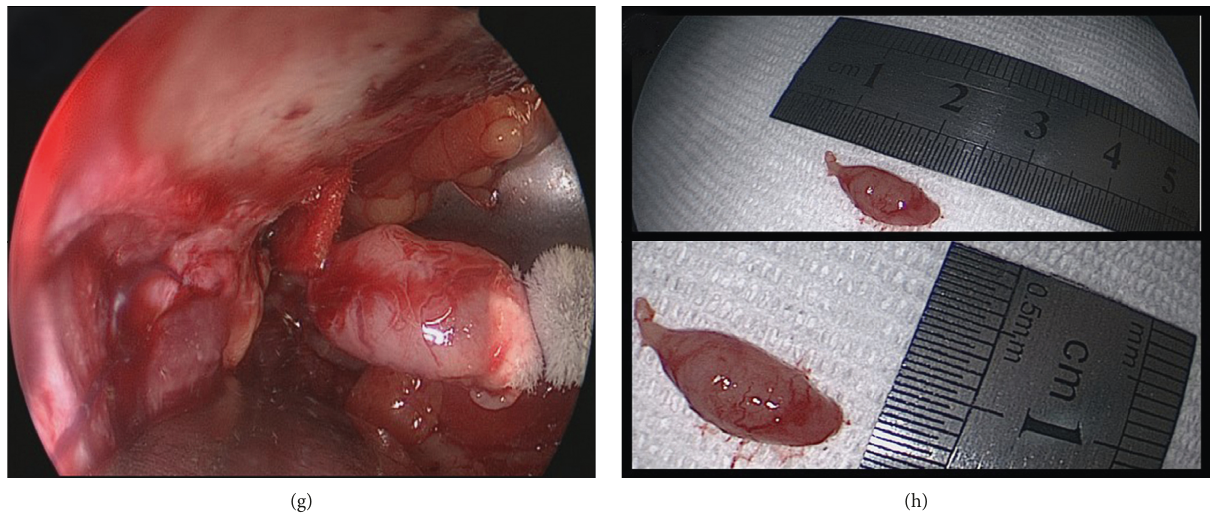
Figure 1: Surgical view of removal of the tumor at the lateral orbital apex with a navigation-guided endoscope. (a) Matching the patient’s anatomical landmark with imaging date. (b) Lateral orbitotomy removed the lateral wall. (c, d) Removing the lateral wall to expose the apex and access the tumor (white arrow) under a navigation-guided endoscope. (e, f) Intraconal tumor was identified and exposed fully (white arrow). (g) The tumor was removed integrally by cryoextraction. (h) Intact tumor size: 13 ∗